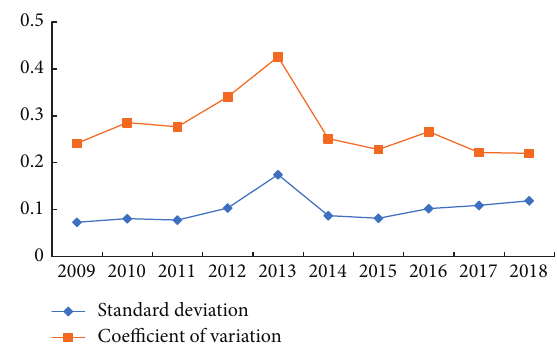
Figure 5: 2009–2018 Beijing, Shanghai, Shenzhen, and Guangzhou urban green development level difference